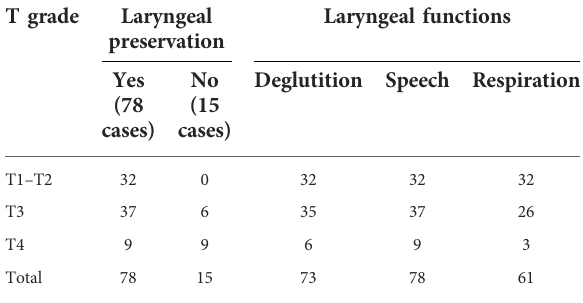
TABLE 4 The preservation of laryngeal functions in different T